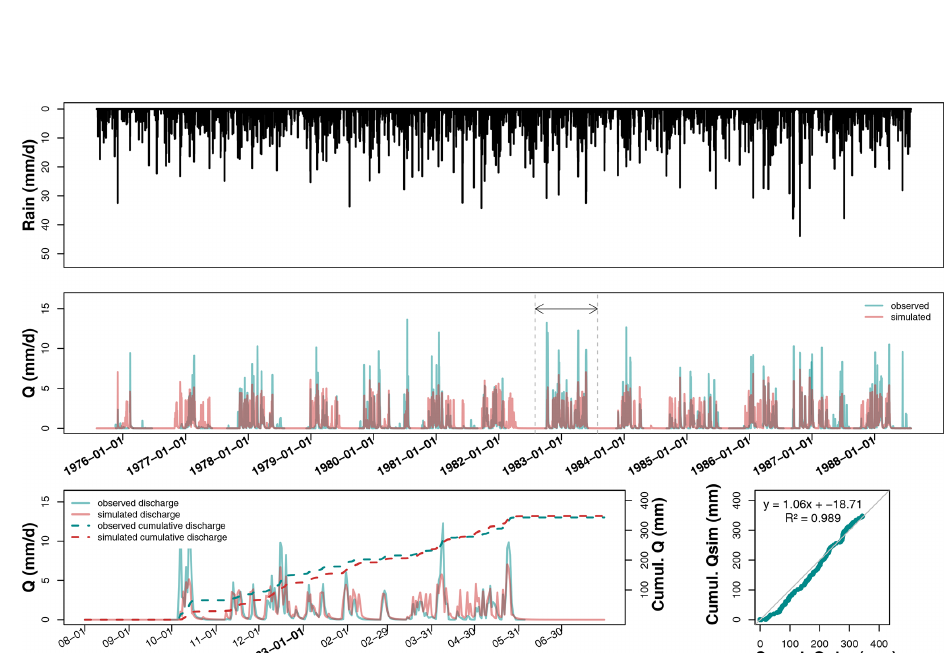
Figure B1. Hydrograph on La_Bouzule_P2 after calibration over the entire available record, plus a magnified plot of hydrological year 1982– 1983 and the associated temporal and direct comparisons between observed (blue curve) and predicted (red curve) cumulative